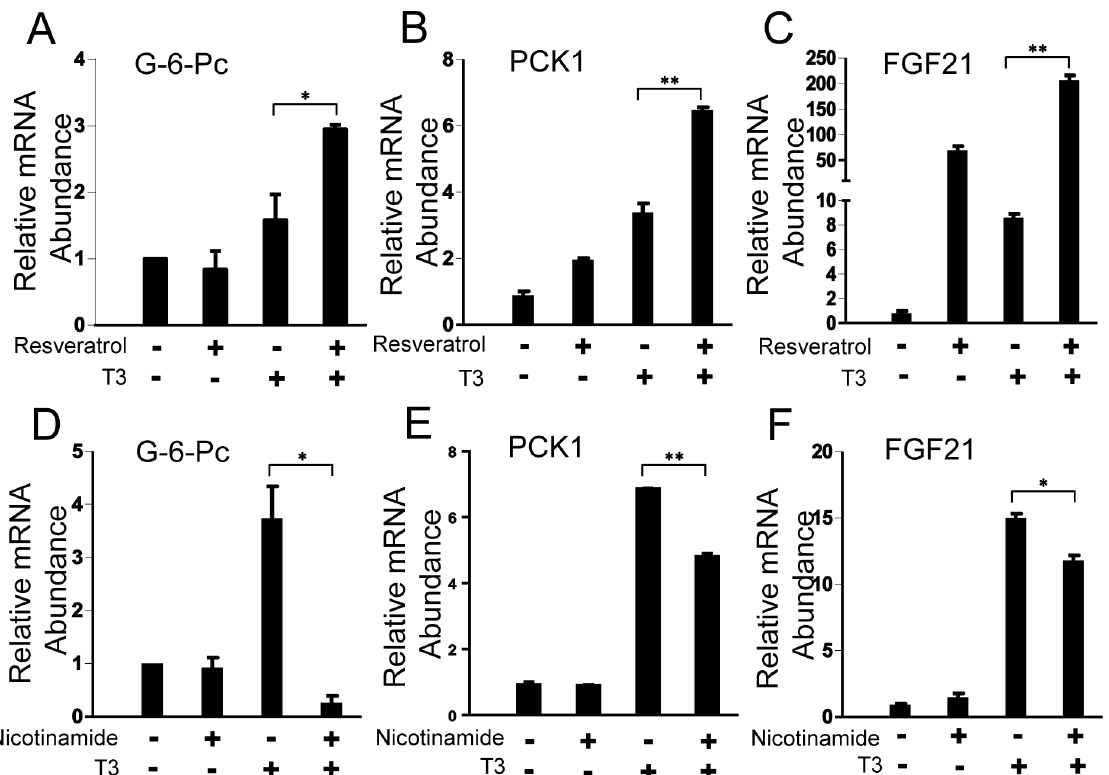
Figure 10. A Small Molecule SIRT1 activator and inhibitor regulate expression of TR b 1 target genes. (A , C) qPCR analysis performed upon HepG2-TR b cells treated with 100 m M resveratrol + / 2 T 3 . Genes are indicated at top. (D , F) As for 10A–C, except that cells were treated with 10 mM nicotimamide instead of resveratrol. Data are representative of at least two independent experiments. All values represent the mean 6 SD of duplicate samples. *, P , 0.05; **, P ,